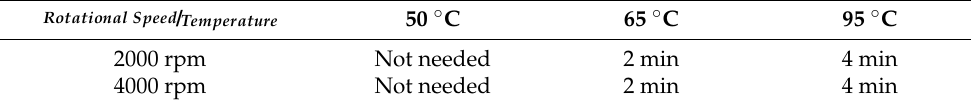
Table 4. Post-exposure bake temperatures and times for SU-8